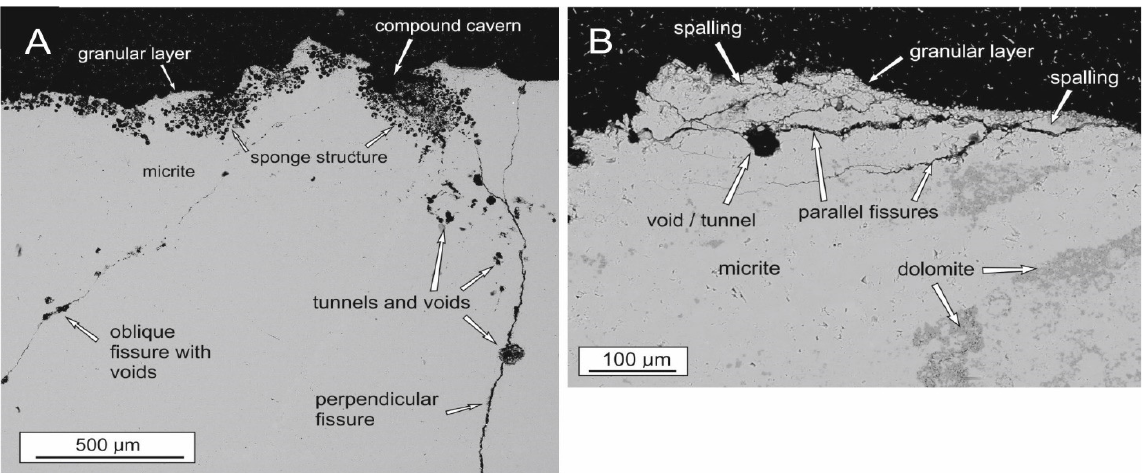
Figure 14. Weathering rind at site 4 (subject to the weathering for 105–106 years); ( A )—well-developed sponge structure in concavities and deep tunnels and voids along oblique and perpendicular fi ssures; ( B )—well-developed fi ssuring on a protruding rock fragment leading to spalling (images from FE-SEM).